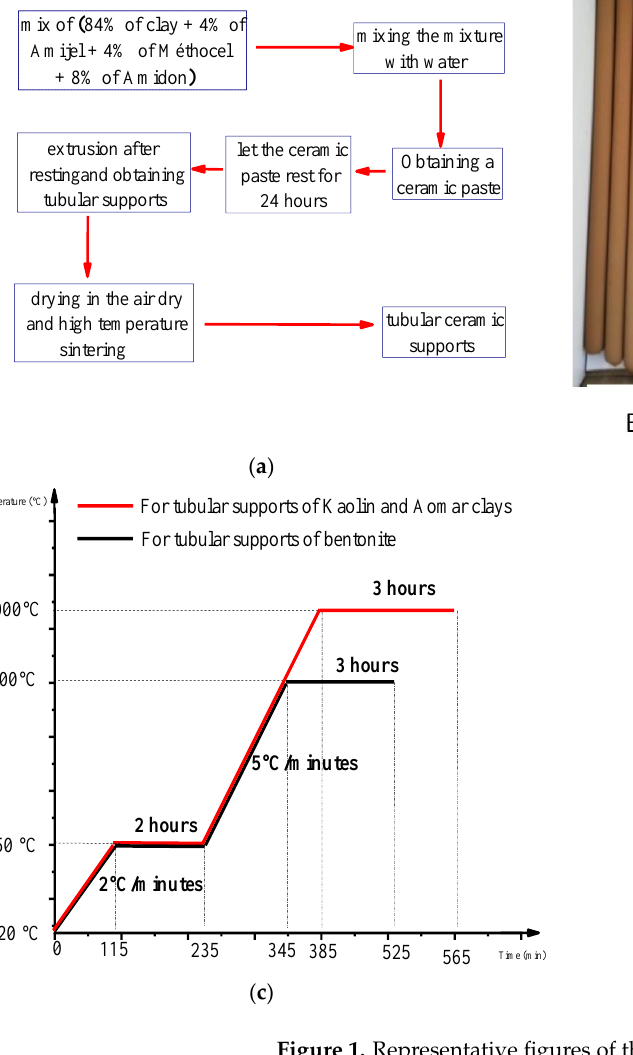
Figure 1. Representative figures of the ( a ) flowchart of the main procedures followed for the elabora- tion of tubular ceramic supports, ( b ) tubular supports obtained for each type of clay, ( c ) schematic representation of the thermal program followed for the sintering of the tubular supports and ( d ) schematic representation of used filtration